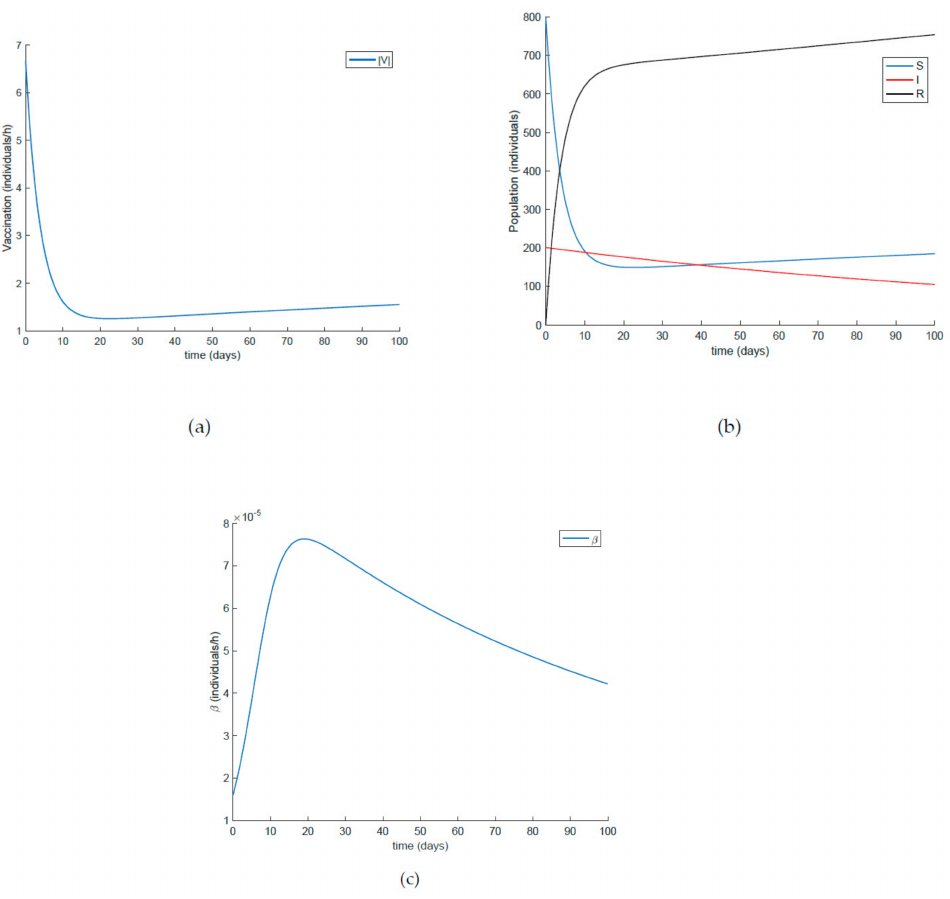
Figure 10. Results obtained when vaccination of the newcomers is added to the control of the contagion rate and the constant vaccination to the susceptible subpopulation, ( a ) vaccination control, ( b ) populations, ( c ) transmission rate.